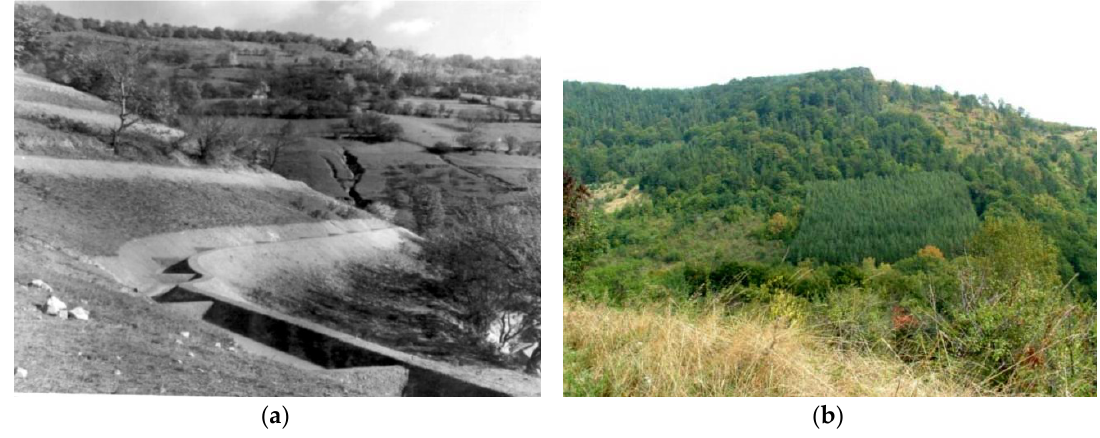
Figure 3. Contour ditches and afforestation of bare land: ( a ) 1953 [58]; ( b ) 2016 (photo: S. Braunovi ć ).